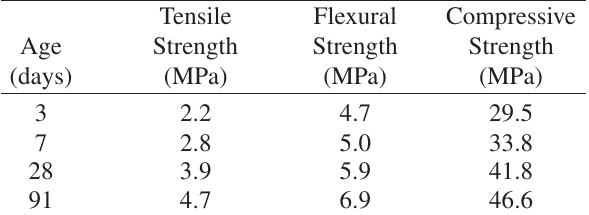
Table 3. Mechanical Properties of C40